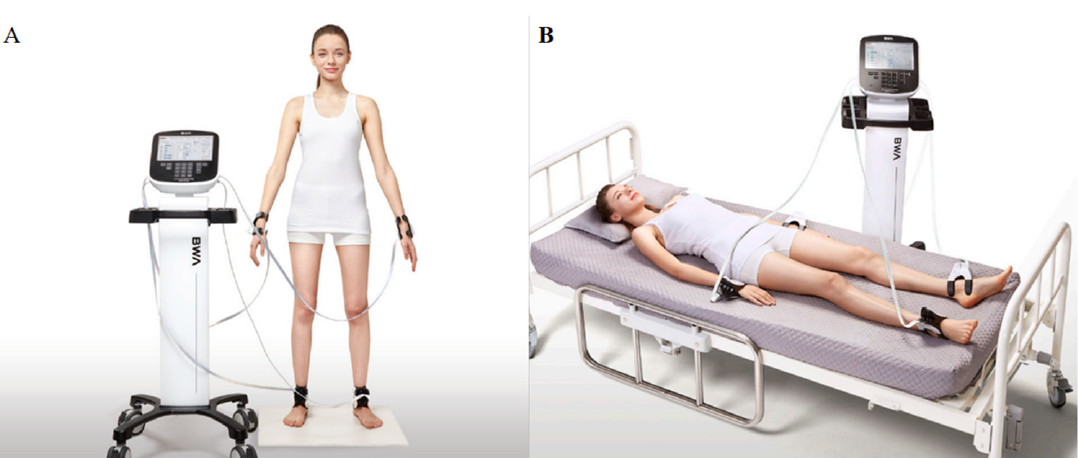
Figure 2. Method of analysis body compositions using Inbody 770. ( A ) Measured by standing position; ( B ) measured by supine position.